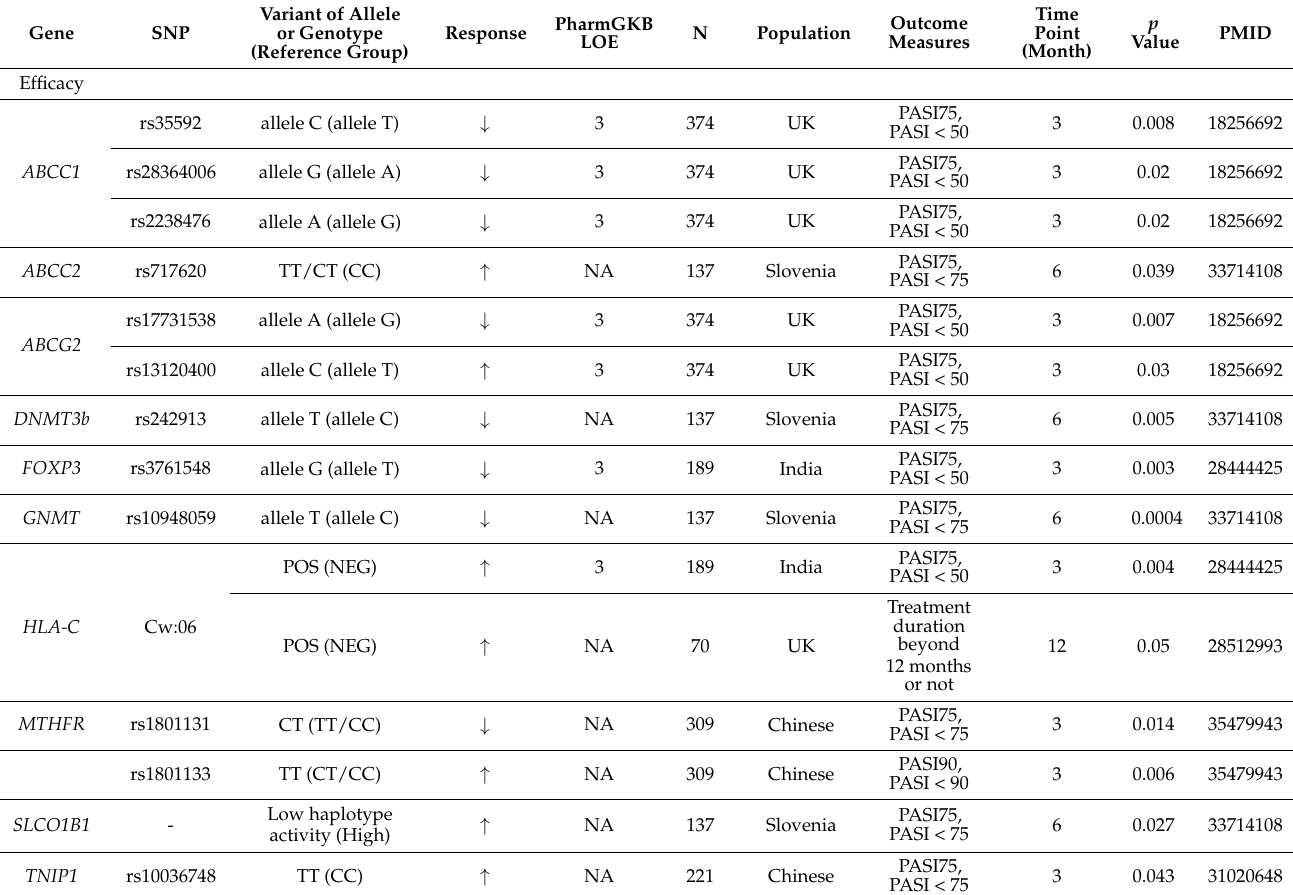
Table 1. Genetic polymorphisms associated with response of methotrexate in patients with